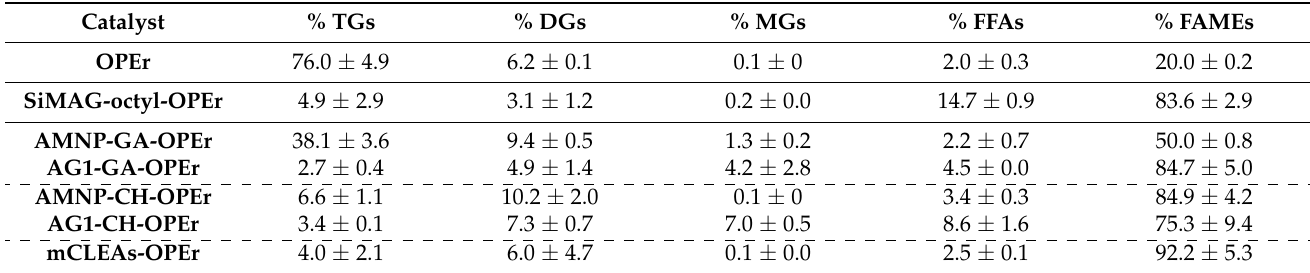
Table 2. Composition of the mixture obtained after 24 h of reaction of discarded cooking oil and methanol catalyzed by OPEr and its